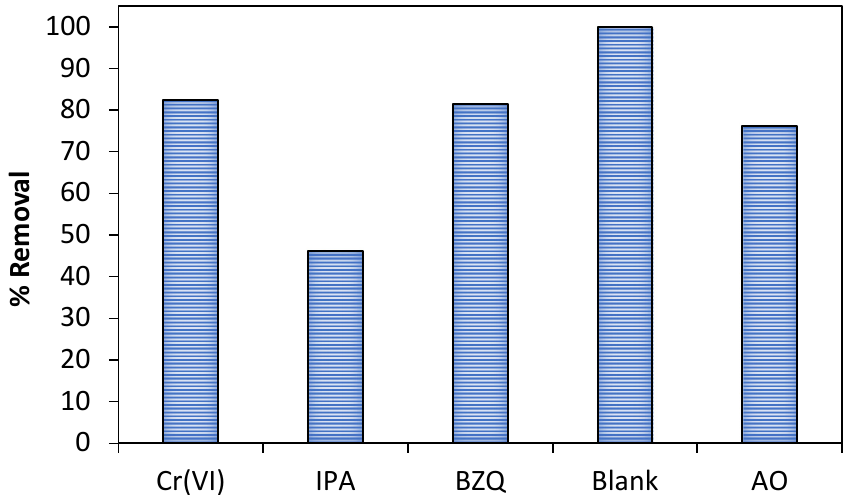
Figure 7. Photocatalytic degradation of RR198 over Fe 2 O 3 /B/TiO 2 in the presence of scavengers.